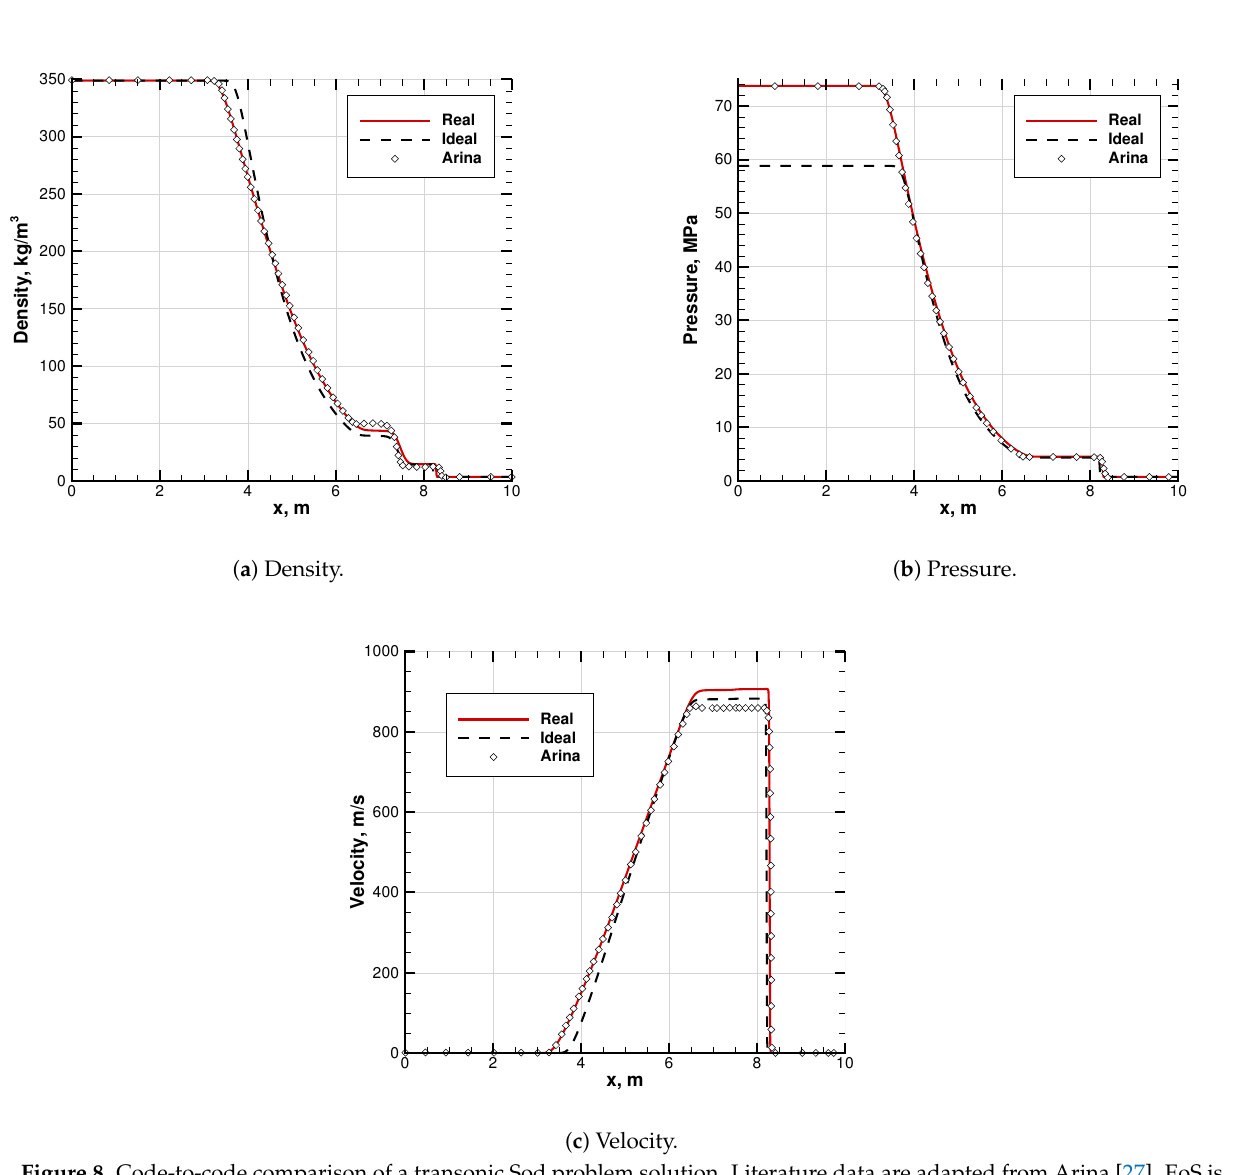
Figure 8. Code-to-code comparison of a transonic Sod problem solution. Literature data are adapted from Arina [27]. EoS is in its SRK mode, while Arina uses plain Redlich–Kwong EoS. Species is pure CO 2 . Initial conditions are listed in Table